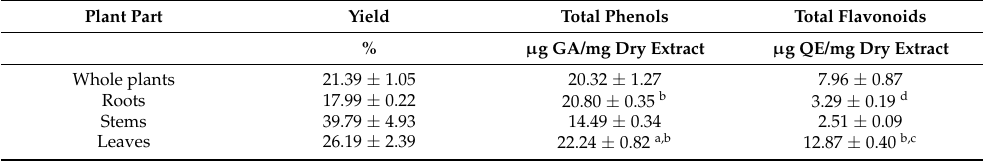
Table 1. Extraction yields, total phenols, and total flavonoids of ethanol extracts from S. ternatum whole plants or specific organs.